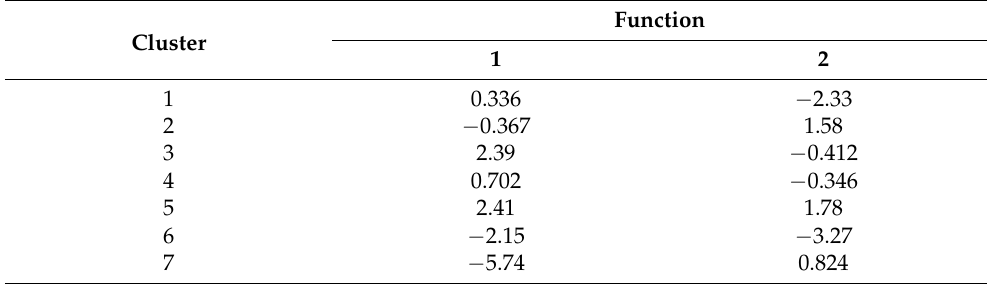
Table 8. Functions at group centroids.